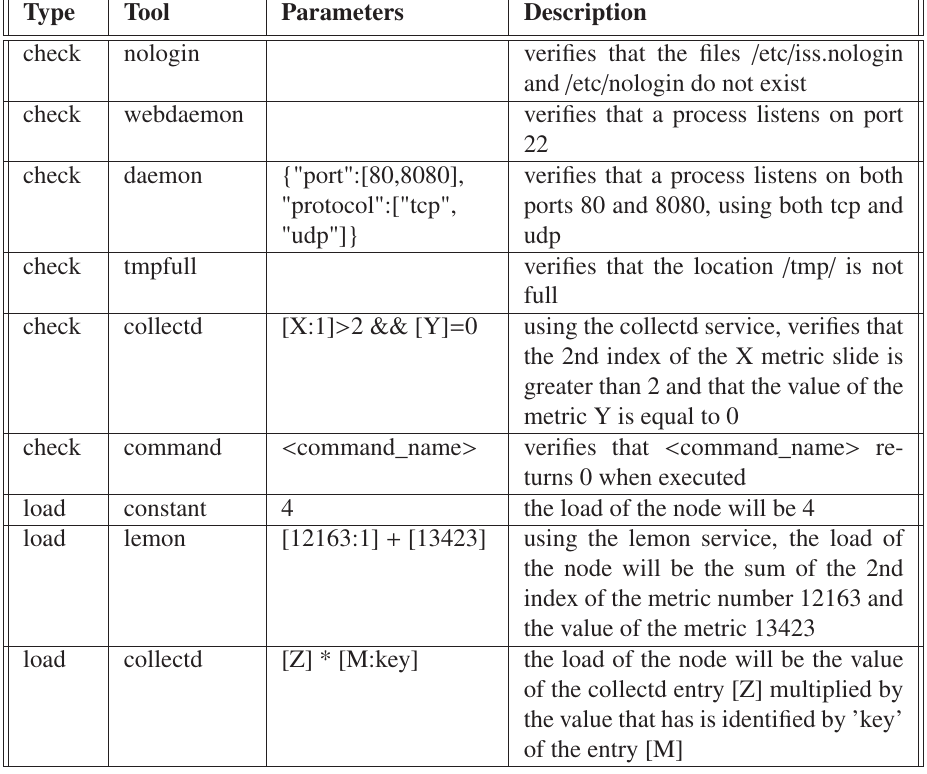
Table 1: Some metrics available when using